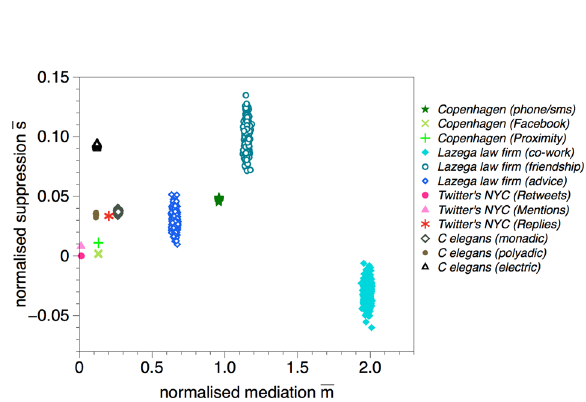
Fig. 6 Normalised suppression-mediation plane for real-world networks. We display the normalised indices of mediation and suppression for four real-world multiplex networks. For each multiplex we permute the role of network C across the three layers, and for each case the speci fi c layer which plays the role of C is highlighted in parenthesis. Dot clouds are the result of repeating the rewiring procedures 500 times (for multiplexes with a large number of nodes, the fi gure displays very little dispersion, and the cloud is only perceptible for the Lazega triplet which is indeed the smallest